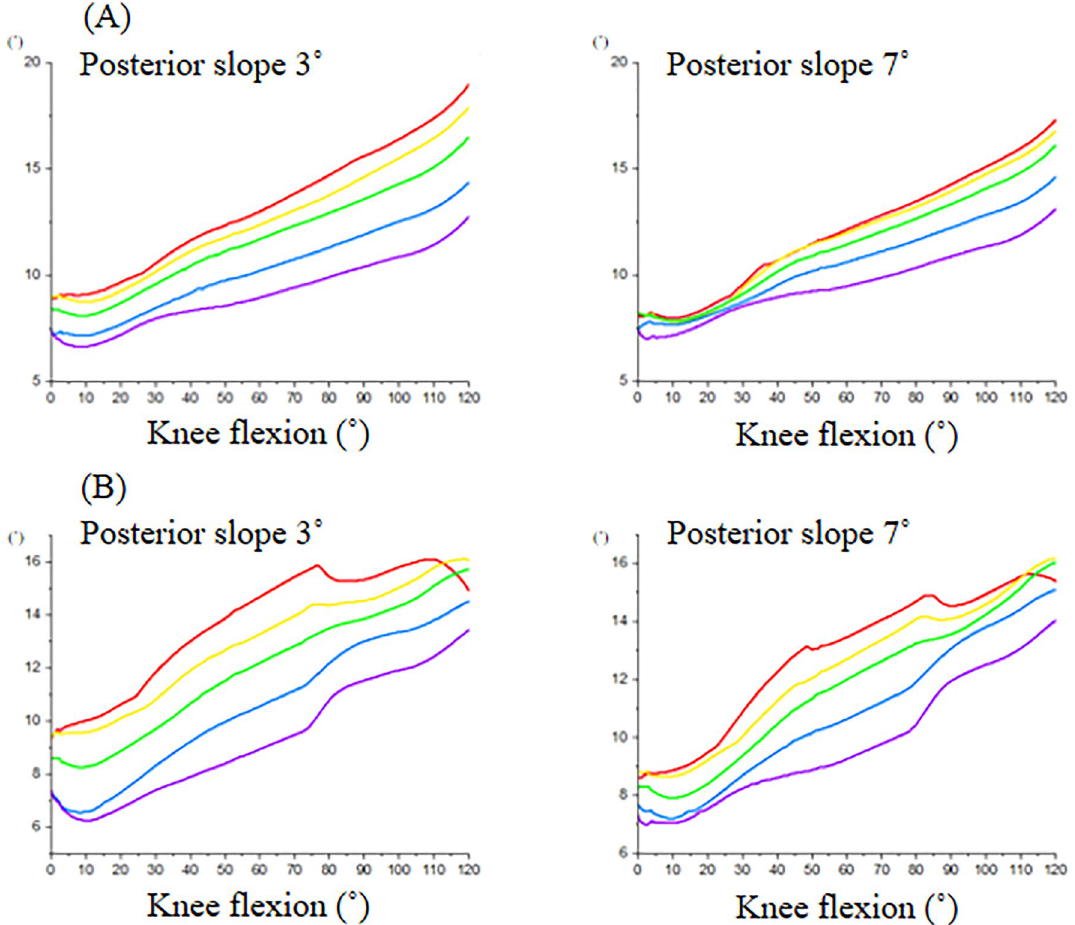
Figure 6. Q angle during knee flexion. ( A ) Cruciate-retaining design, ( B ) posterior-stabilized design. Comparison between the tibial rotational alignments (red: internal 10°, yellow: internal 5°, green: neutral, blue: external 5°, purple: external 10°).